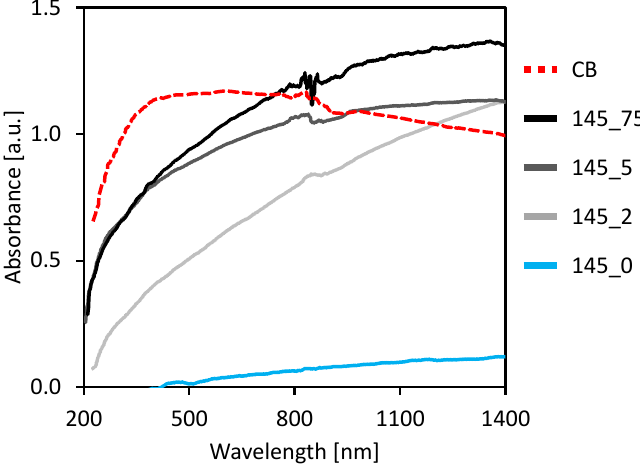
Figure 6. UV/VIS/NIR absorption spectra of the four membranes and of carbon black.